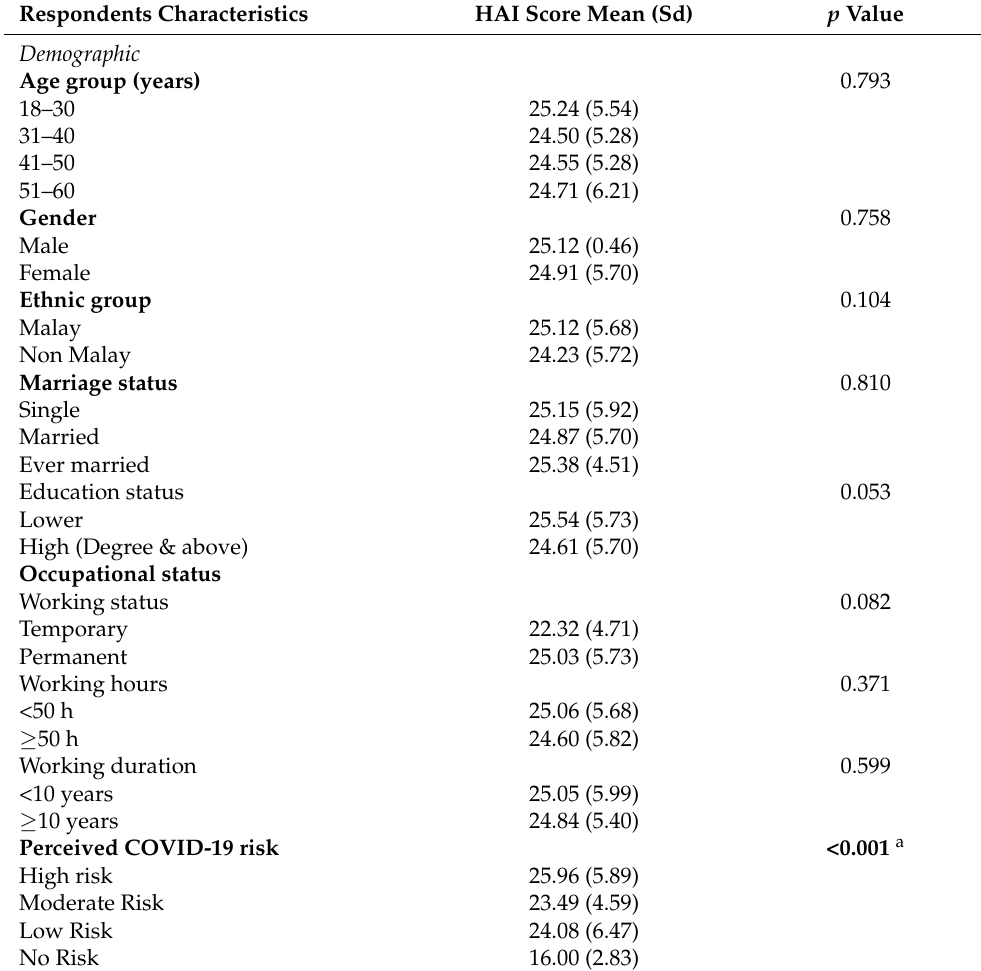
Table 3. Bivariate analysis of sociodemographic, work characteristics, self-perceived risk and Health Anxiety Inventory mean